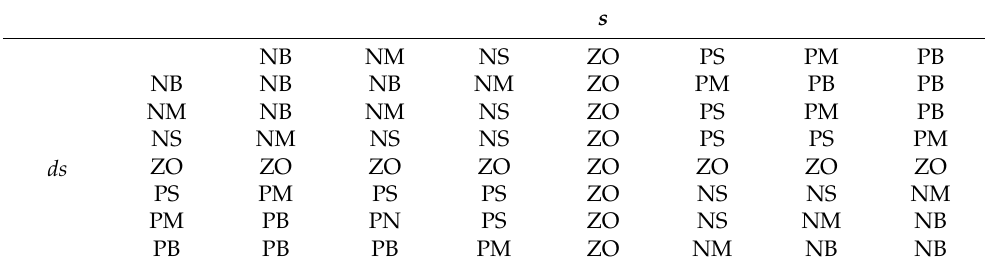
Table 1. Fuzzy rule table [37].